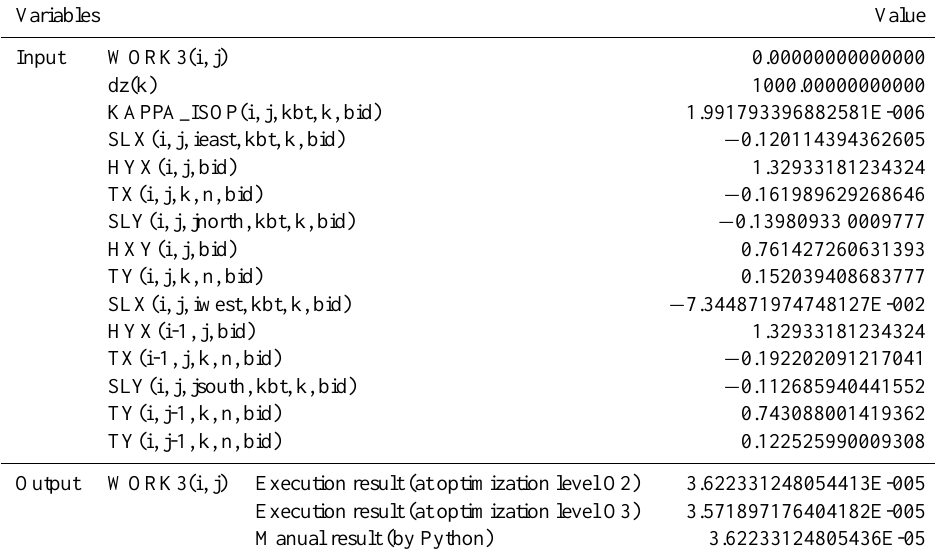
Table 17. An example of obvious different results in lines 1923–1932 of Fig. 3 when changing the compiler optimization levels (from O2 to O3). A manual result calculated by Python is also